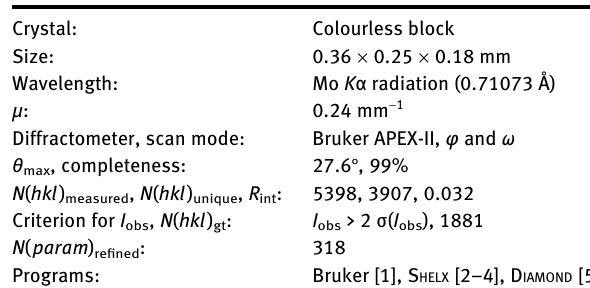
Table  : Data collection and